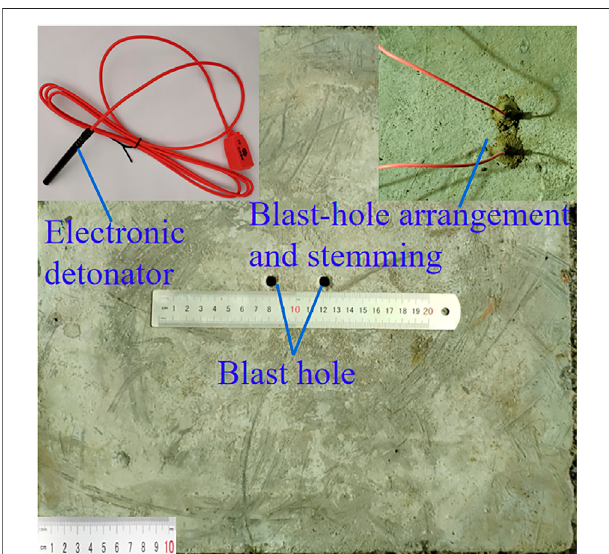
FIGURE 2 | Test block hole layout and plug hole.